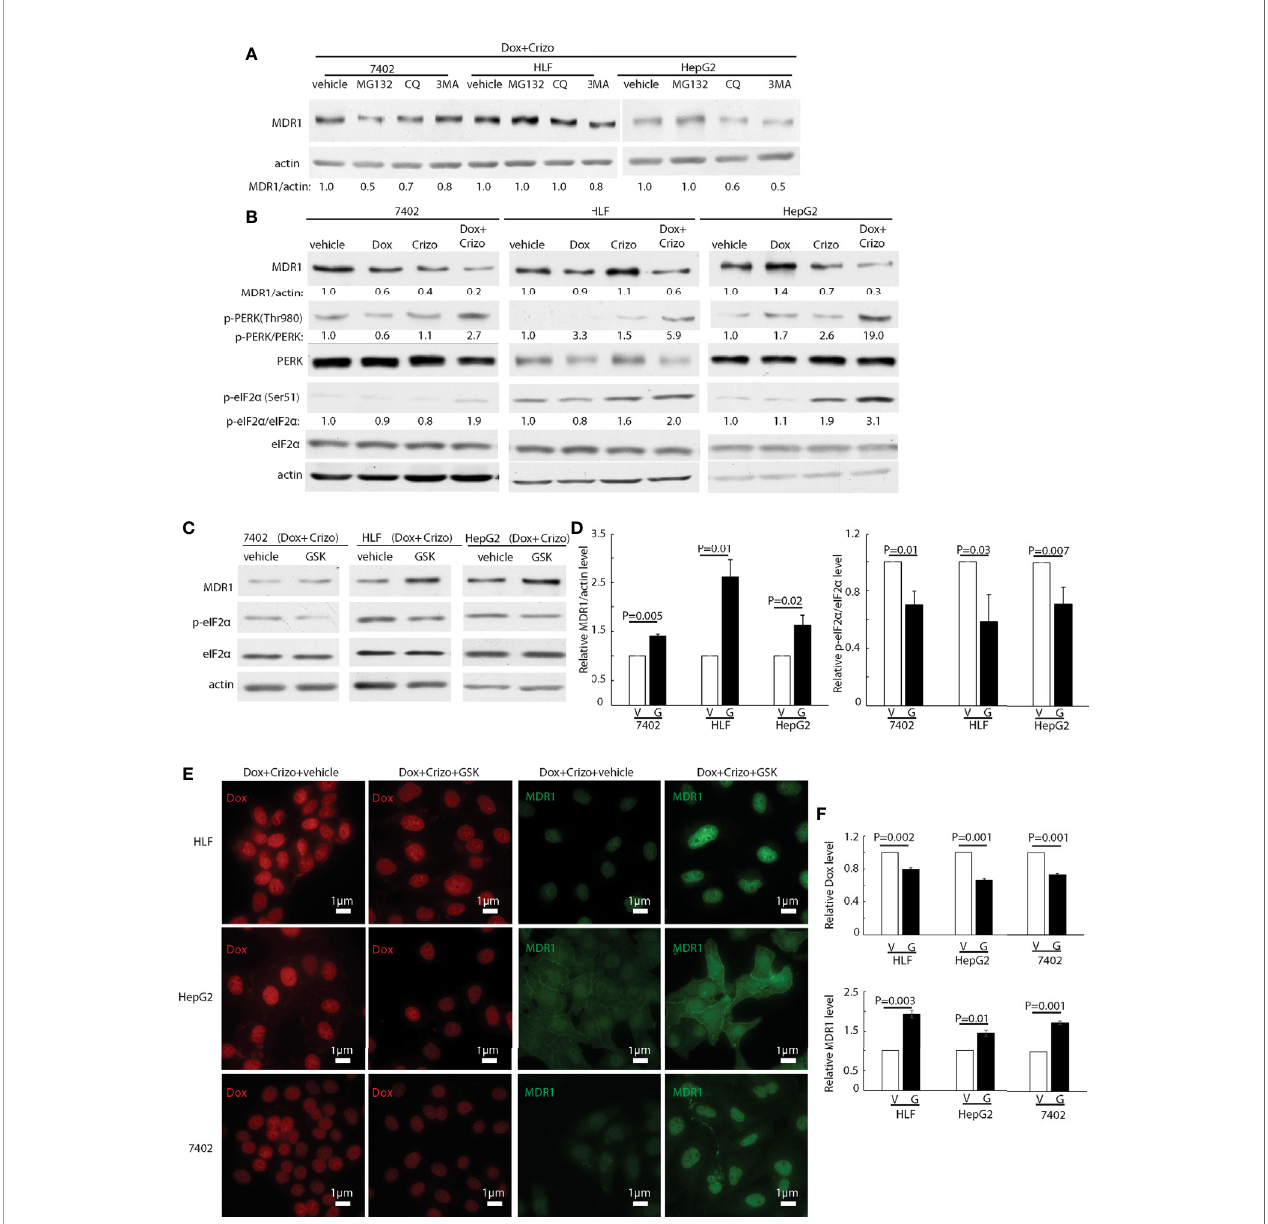
FIGURE 4 | Crizo plus Dox treatment of HCC cells mitigates MDR1 expression by increasing PERK-eIF2 a phosphorylation. (A) HCC cells treated with Crizo (5 m M) plus Dox (0.85 m M) were incubated with inhibitors for proteasome, autophagy, or lysosome at the same time and cell lysates were blotted with antibodies speci fi c against MDR1 or actin. No signi fi cant increase of MDR1 was detected after protein degradation was inhibited by various inhibitors. (B) Obviously more phosphorylation of PERK and eIF2 a was detected in cells treated with Crizo (5 m M) plus Dox (0.85 m M) than in cells treated with vehicle, Dox (0.85 m M), or Crizo (5 m M) only. Cell lysates from cells under drug treatment for 24 hs were blotted with antibodies speci fi c for indicated proteins, obviously more p-PERK and p-eIF2 a signals were observed from cells treated with Crizo plus Dox. (C) Signi fi cantly more MDR1 was detected from cell lysates after the cells were treated with GSK, a speci fi c inhibitor to PERK, for 2 hs. Effects of GSK on PERK were revealed by immunoblotting against p-eIF2 a . Cells were treated with Crizo (5 m M) plus Dox (0.85 m M) for 22 hs and then vehicle or GSK were added for an additional 2 hs before cell lysates were made. (D) Open and fi lled in bar graphs represented the mean and standard deviation from three experiments. (E) Immuno fl uorescence staining for MDR1 showed that 2 hs after GSK addition, obviously more MDR1 was detected in cells treated with Crizo (5 m M) plus Dox (0.85 m M) (the 4 th column). In contrast, much less MDR1 was detected in HCC cells treated with vehicle under the same condition (the 3 rd column). Obviously more Dox was detected in cells treated with vehicle (the 1 st column) whereas much less Dox was observed in cells treated with GSK (the 2 nd column). (F) Open and fi lled in graphs represented the mean and standard deviation from three experiments. Relative immuno fl uorescence intensity or protein levels were determined with IMAGE J as speci fi ed. The experiments were repeated at least three times with similar results. V, vehicle; G, GSK. P values were